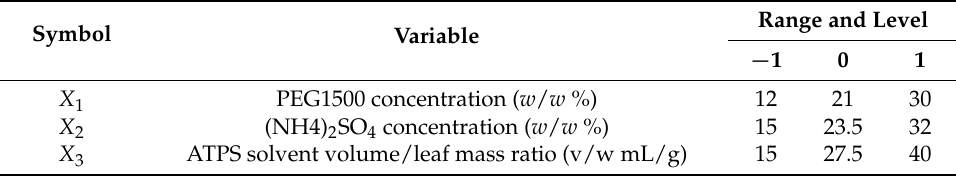
Table 1. Parameters and levels for Box–Behnken design. PEG: polyethylene glycol. Symbol